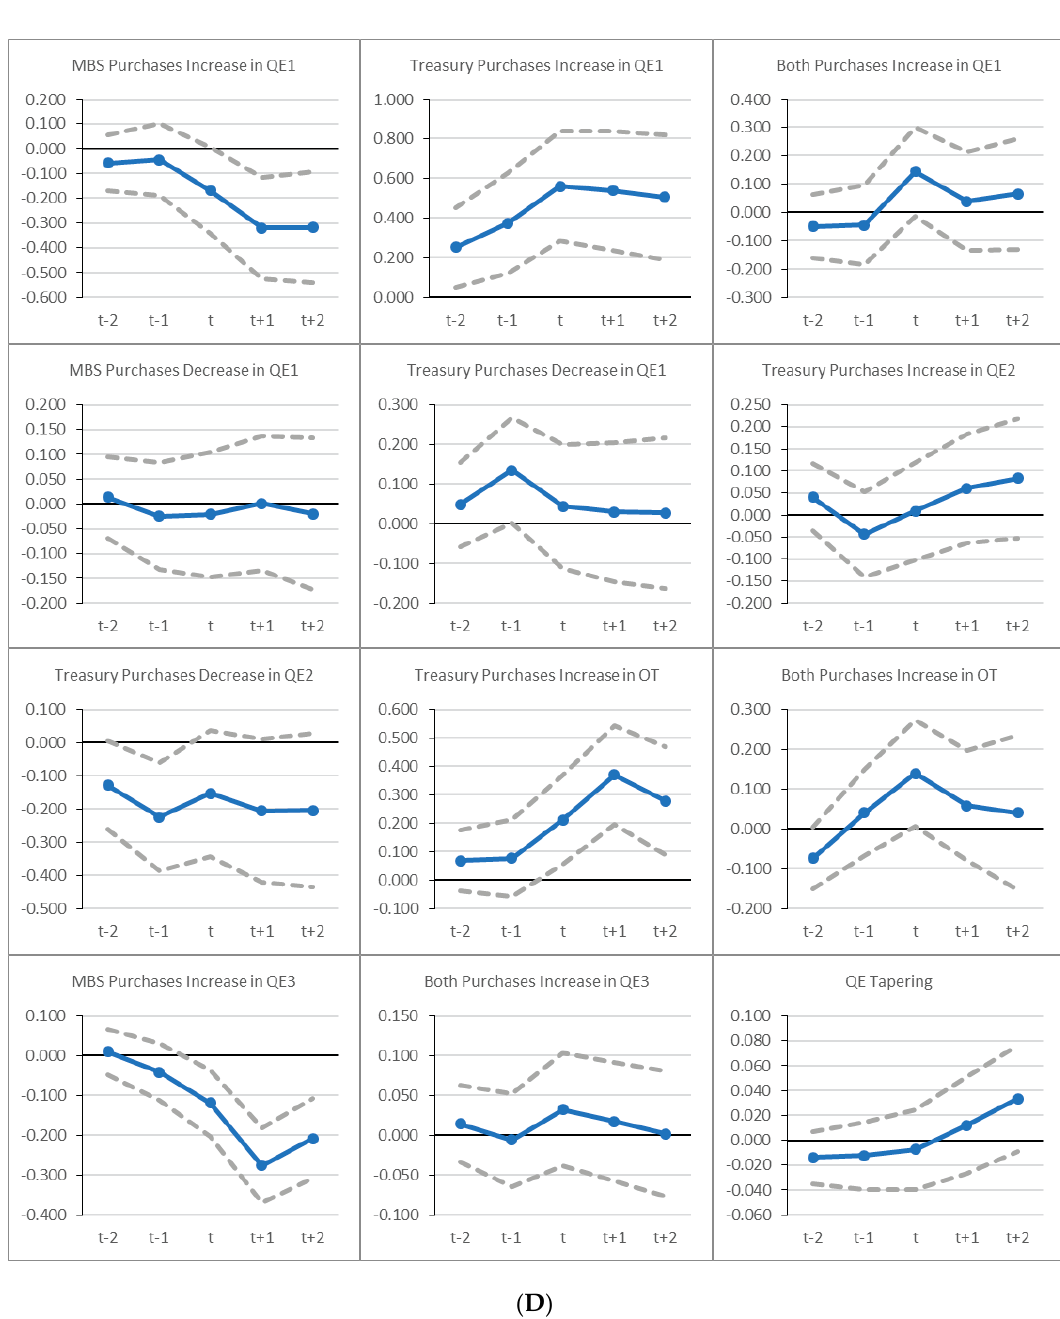
Figure 2. Cumulative abnormal returns (CARs) on days in a 5-day window of grouped event. The CAR on each day inside a 5-day event window for grouped events are reported in the figure. Each CAR is calculated as a summation of abnormal returns from two days before the event day ( t − 2) to the day interested. The region between two dash lines in each graph is the 95 percent confidence interval of ARs. t indicates the event day. Panel ( A ) CARs of 30-year mortgage rate (market regression); Panel ( B ) CARs of 30-year mortgage rate (constant mean return regression); Panel ( C ) CARs of 30-year Treasury rate; Panel ( D ) CARs of spread between 30-year mortgage rate and Treasury rate.